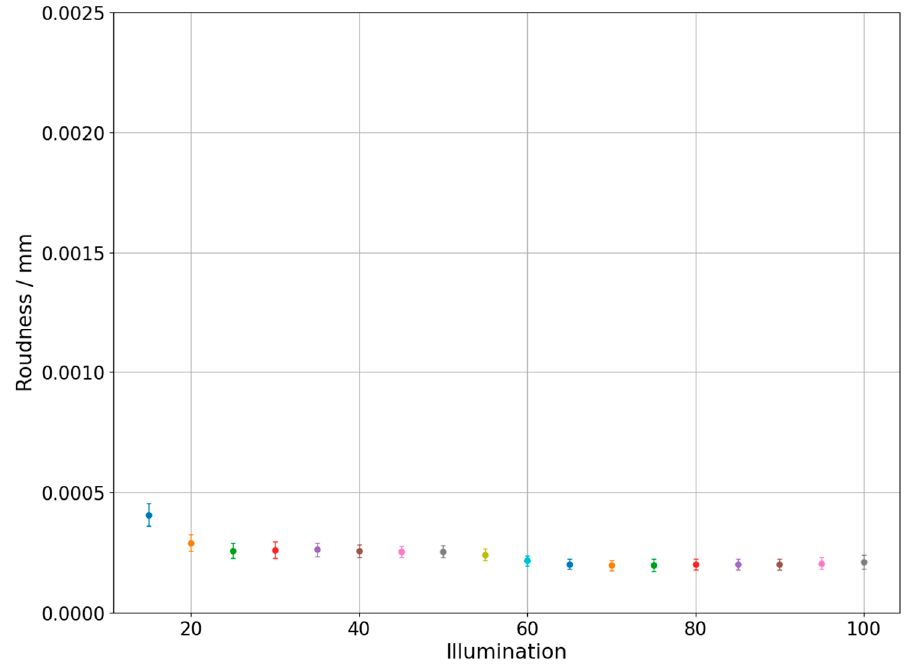
Figure 7. Roundness changes depending on the applied backlight. Glass plate standard measurement.